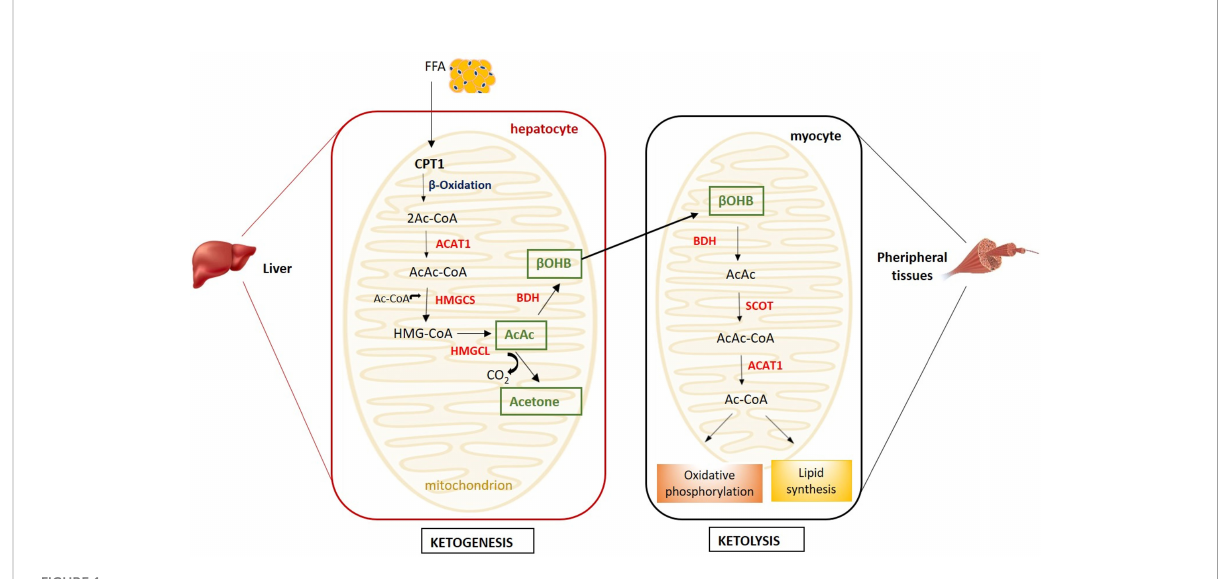
FIGURE 1 Metabolism of ketone bodies. Ketogenesis takes place in hepatocyte mitochondria, while ketolysis in the mitochondria of peripheral tissues (i.e. muscle, heart, kidney and brain). (ACAT1, acetyl coenzyme A acetyltransferase; AcAc, acetoacetate; Ac-CoA, acetyl-CoA; AcAc-CoA, acetoacetyl-CoA; BDH, b -hydroxybutyrate dehydrogenase; b OHB, b -hydroxybutyrate; CPT1, carnitine palmitoyltransferase 1; FFA, free fatty acids; HMGCL, HMG-CoA lyase; HMG-CoA, b -hydroxy- b -methylglutaryl-CoA; HMGCS, HMG-CoA synthase; SCOT, succinyl-CoA-3-ketoacid- CoA